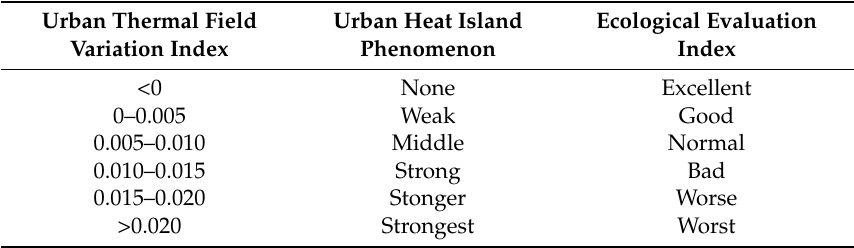
Table 4. Threshold values of the Urban Thermal Field Variance Index (UTFVI) and ecological evaluation index (source: Reference [42]).